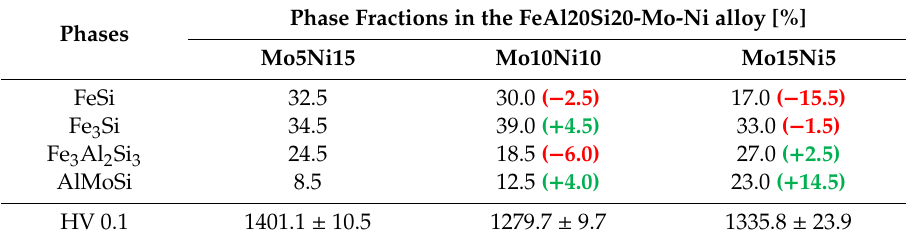
Table 4. Phase fractions and their correlation with the measured hardness of the MA + SPS alloys. (di ff erences from FeAl20Si20Mo5Ni15 are shown in brackets)